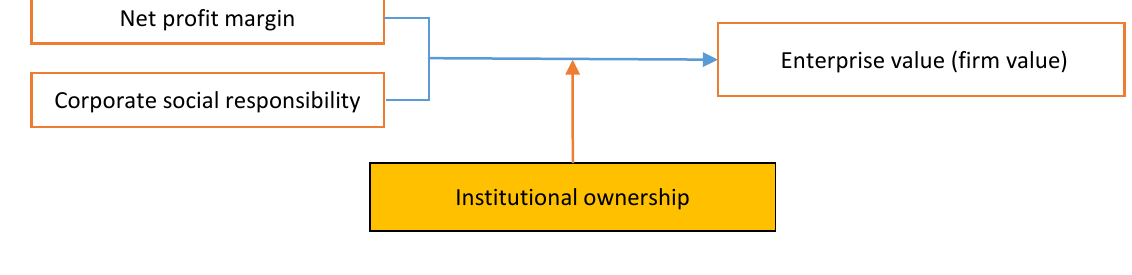
Figure 4. Conceptual framework